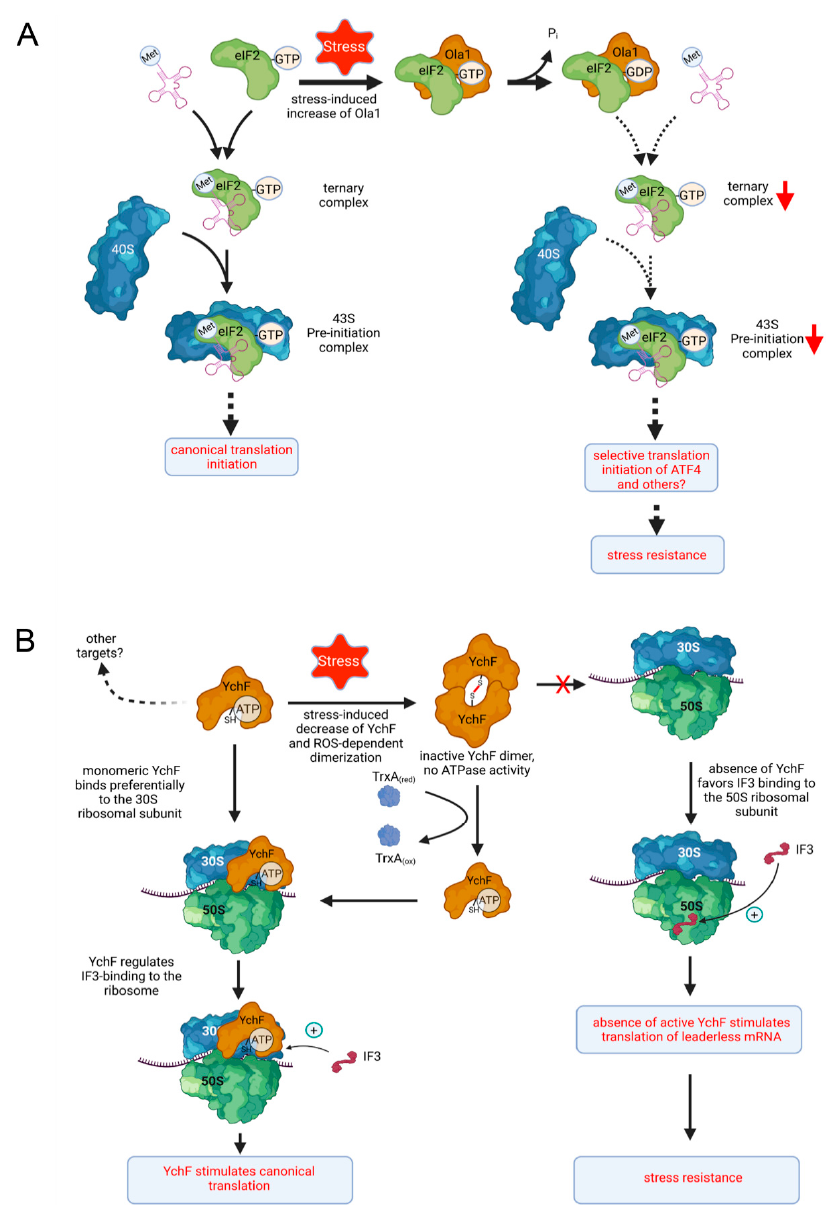
Figure 4. Model of translational regulation by Ola1/YchF. ( A ) In eukaryotes, Ola1 binds to eIF2 and stabilizes eIF2 in its GDP-bound state, which would subsequently reduce the formation of the ternary complex. As a consequence, alternative translation initiation mechanisms are favoured, leading to selective synthesis of stress-response proteins. ( B ) In prokaryotes, such as E. coli , YchF binds preferentially to the 30S ribosomal subunit and regulates IF3-binding to the 30S subunit, which favours canonical translation initiation. Upon stress conditions, ychF expression is reduced and the ATPase activity of YchF is further inhibited by dimerization. The absence of active YchF possibly favours IF3 binding to the 50S subunit and stimulates leaderless mRNA translation. Note that YchF was also found in contact with the 50S ribosomal subunit; this interaction is likely only transient and not depicted here, although it might be involved in regulating IF3 binding to the ribosome. TrxA corresponds to thioredoxin A, which was shown to dissociate the inactive YchF dimer into active YchF monomers [26]. See text for further